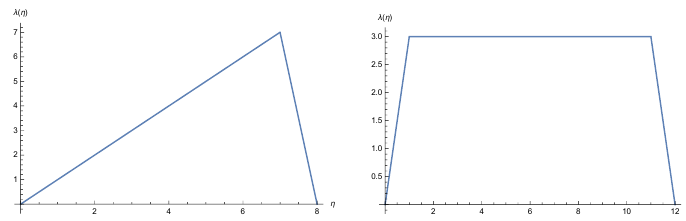
Figure 2 . Charge density (cid:21) ( (cid:17) ) of a \one-kink" spacetime (left) and an \Uluru" spacetime (right) with the values used for the numerical